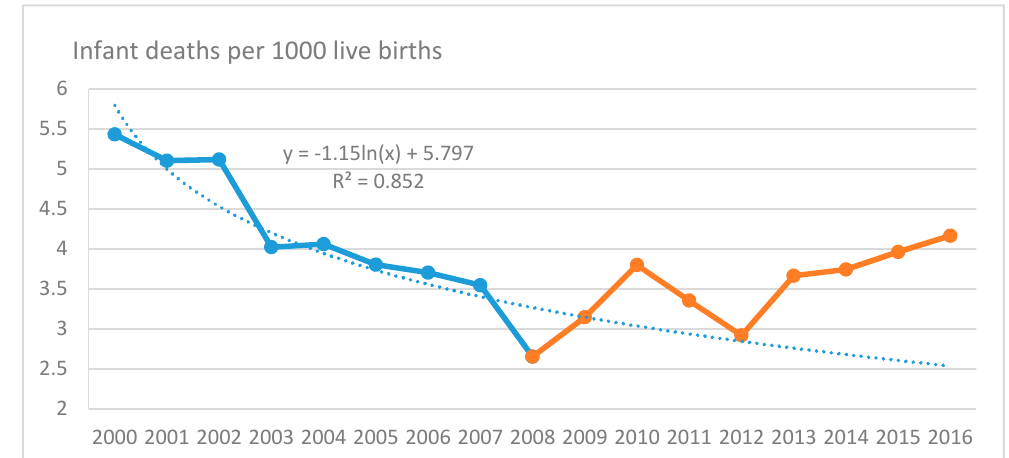
Figure 1. Observed and expected Perinatal Mortality and Infant Mortality rates in Greece, 2009–2016.